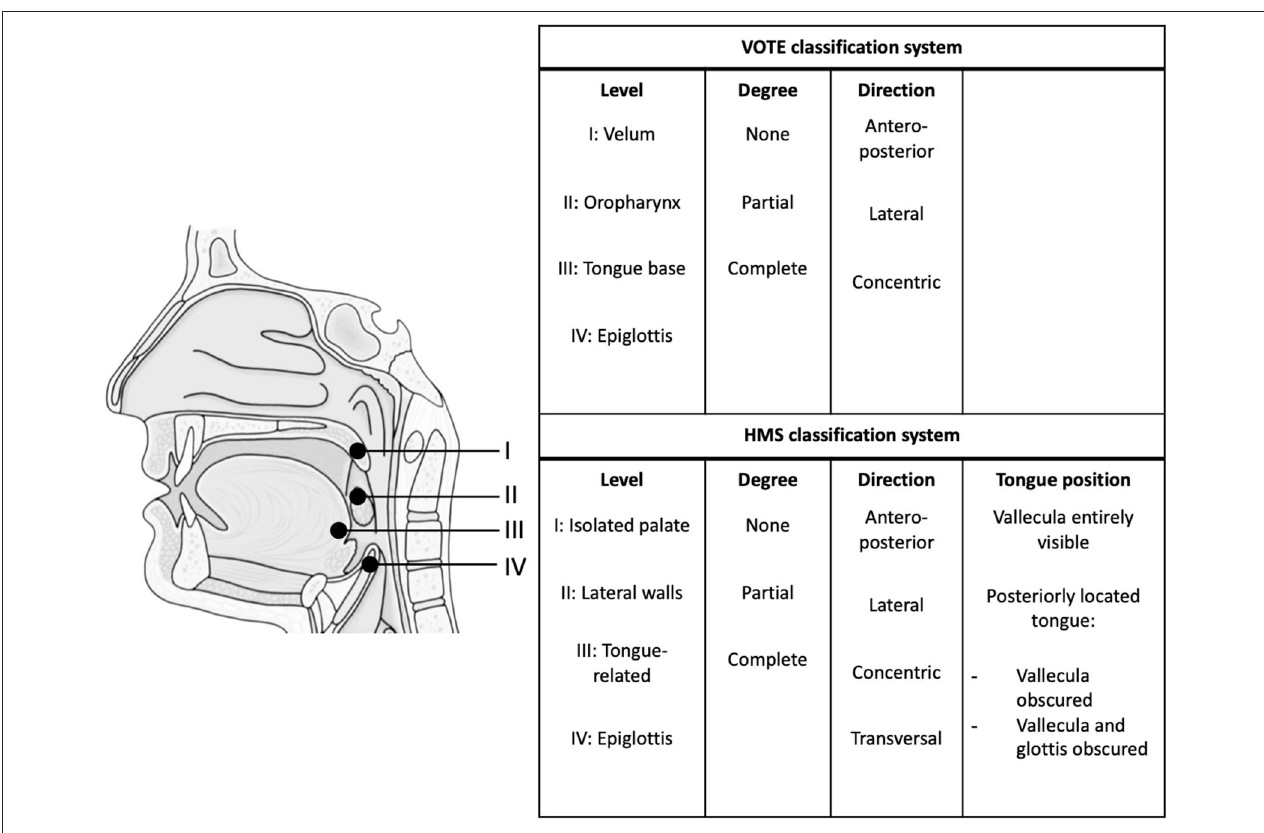
FIGURE 2 | Endoscopic classification systems. HMS, Harvard Medical School. VOTE classification system (26, 46). HMS classification system (22, 27,